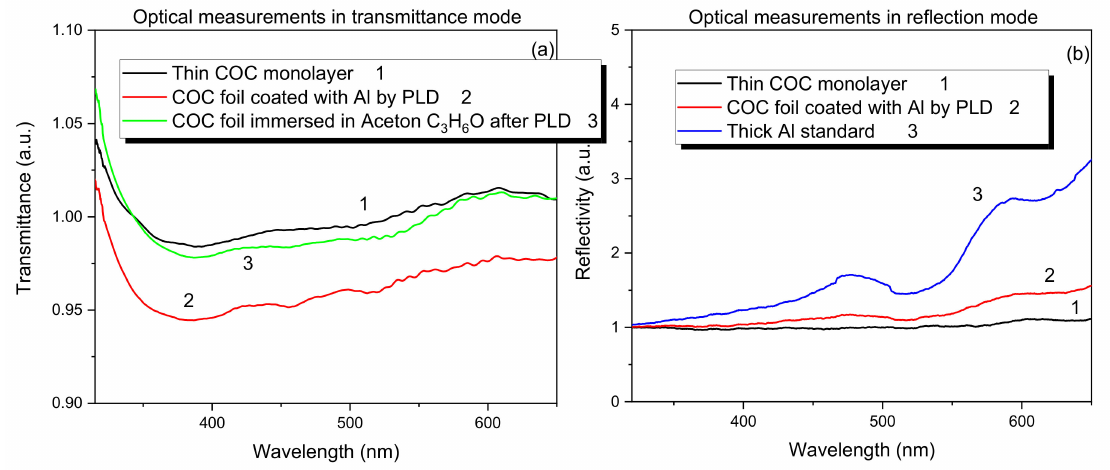
Figure 8. Transmission ( a ) and reflectivity ( b ) for pristine COC and for COC deposited with Al ions.